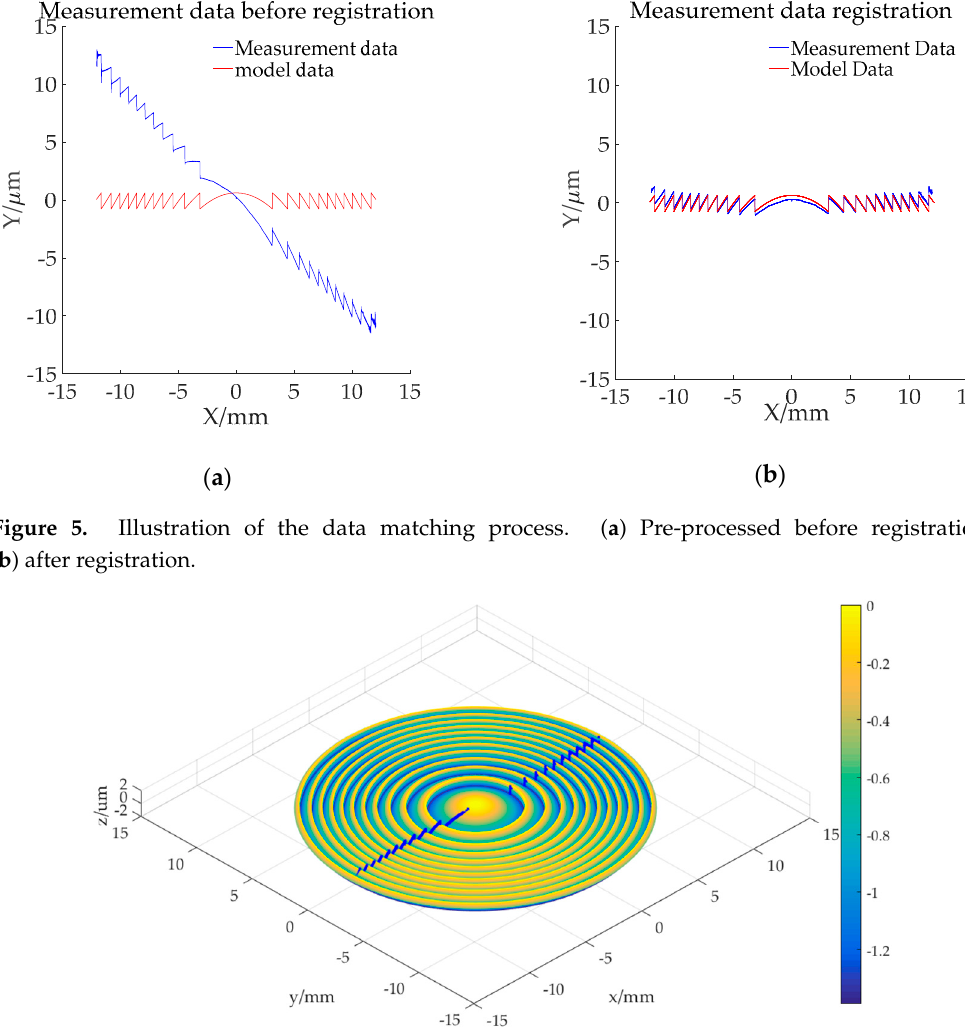
Figure 6. The effect of the measured data matching the 3D design model.